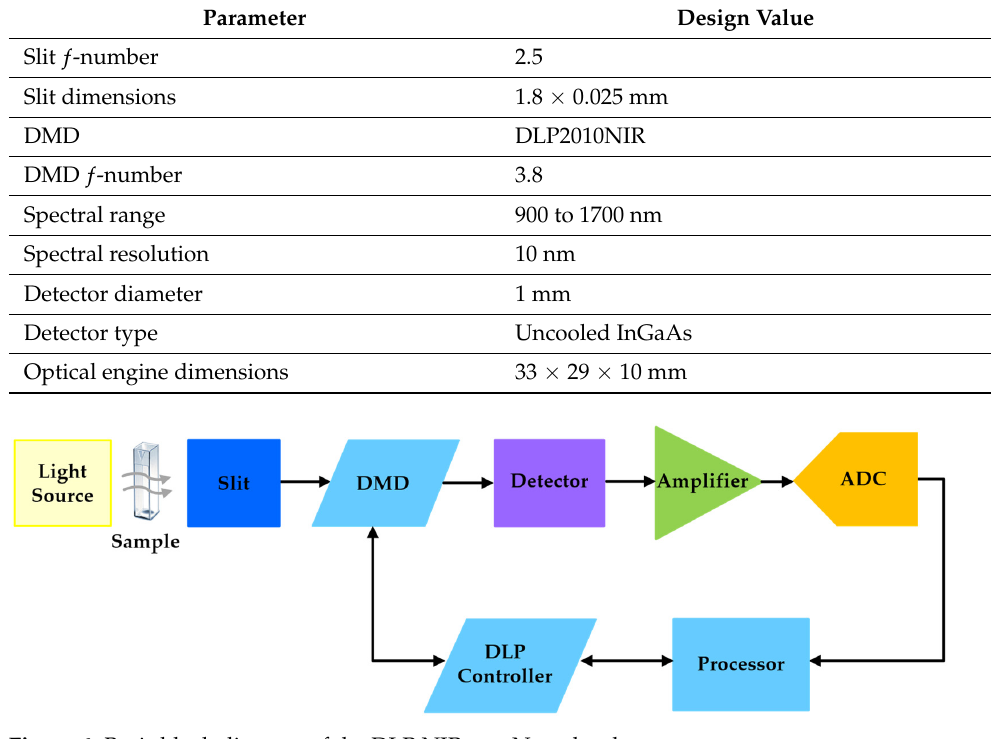
Figure 6. Basic block diagram of the DLP NIRscan Nano hardware.